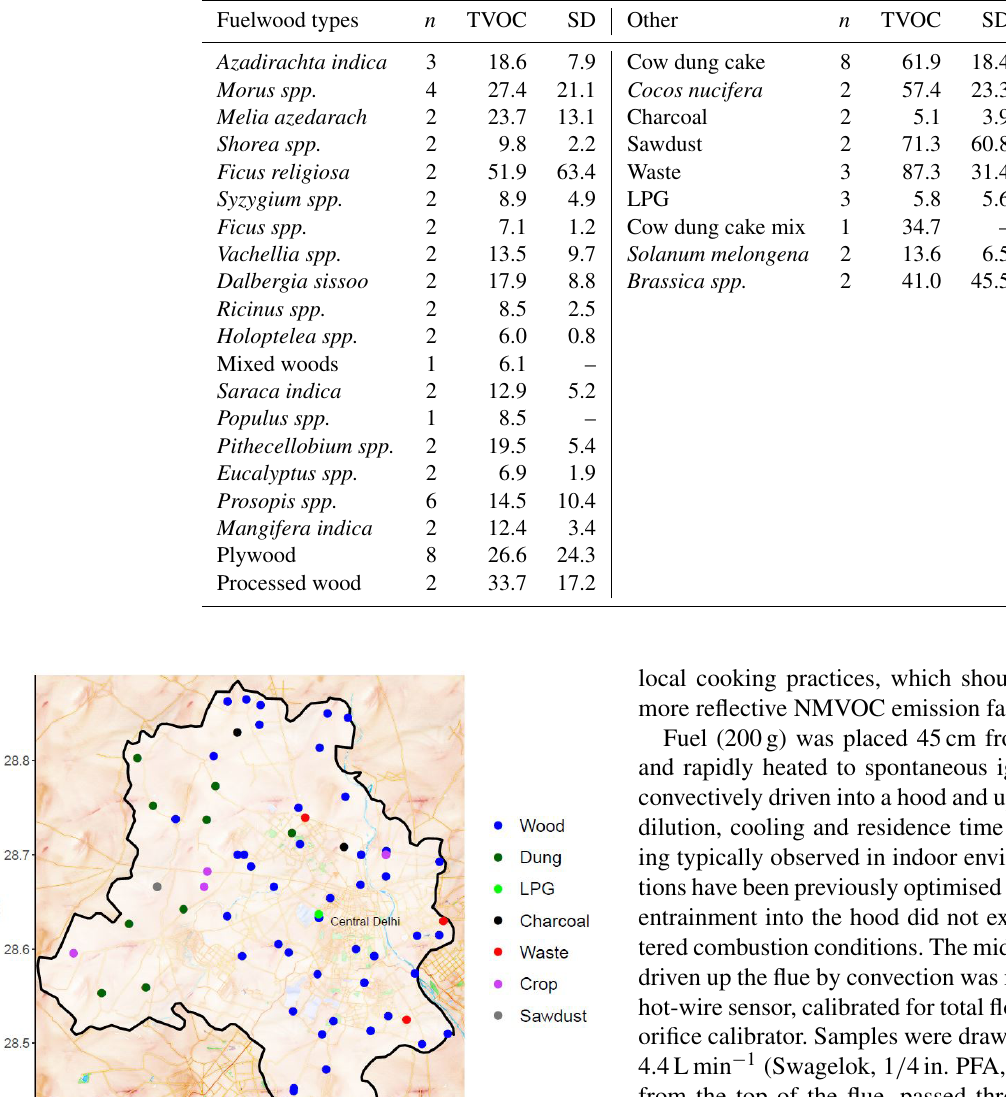
Table 1. Types and numbers of fuel samples burnt, the mean emission factor of total measured NMVOCs (TVOC) in gkg − 1 and standard deviation (SD) from all available burns.